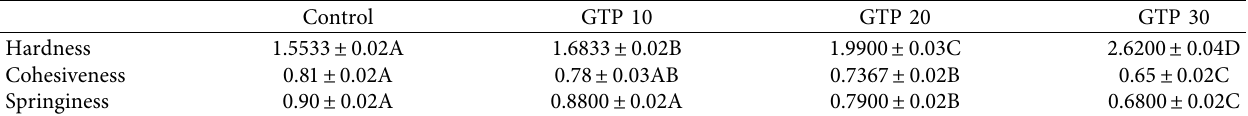
Table 4: Texture profile analysis of various sponge cake samples.